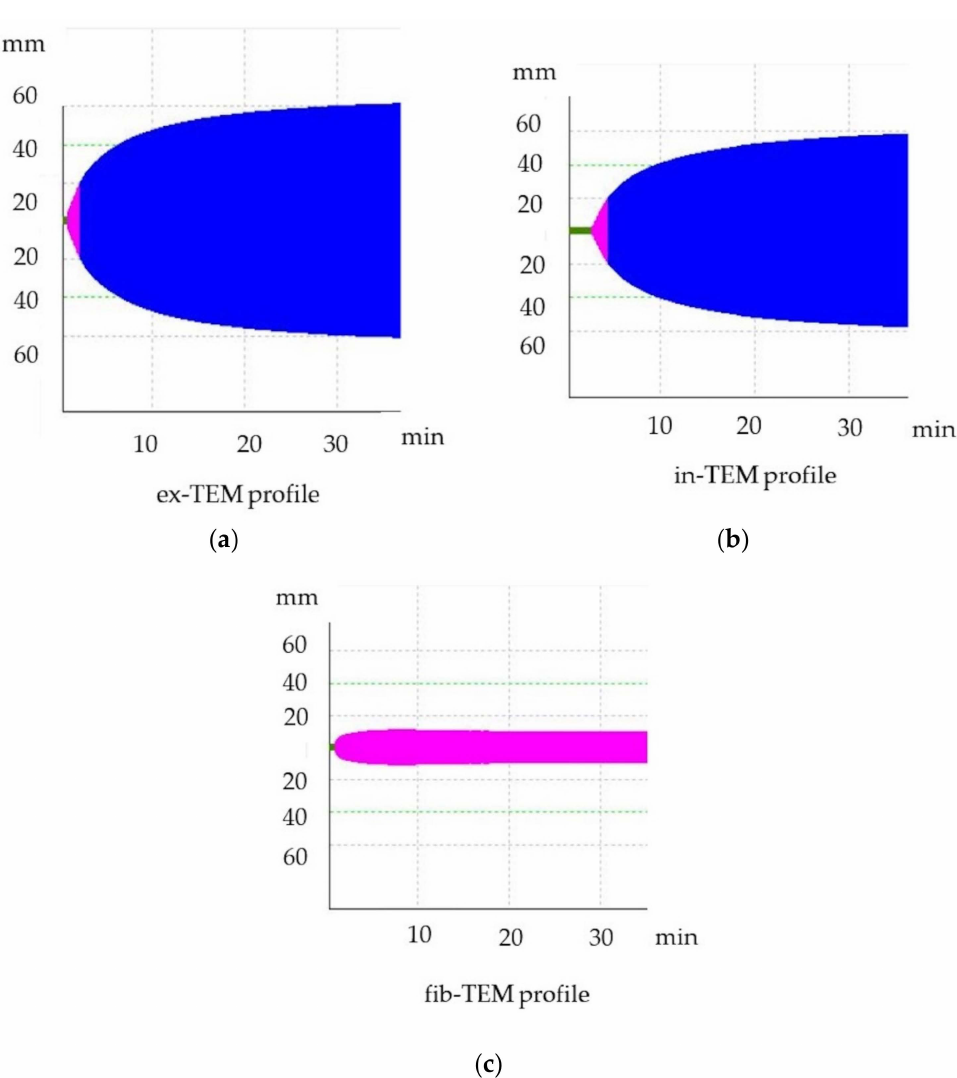
Figure 1. Thromboelastometric tracing of healthy dogs. ( a ) ex-TEM, extrinsic thromboelastometry pathway; ( b ) in-TEM, intrinsic thromboelastometry pathway; ( c ) fib-TEM, functional